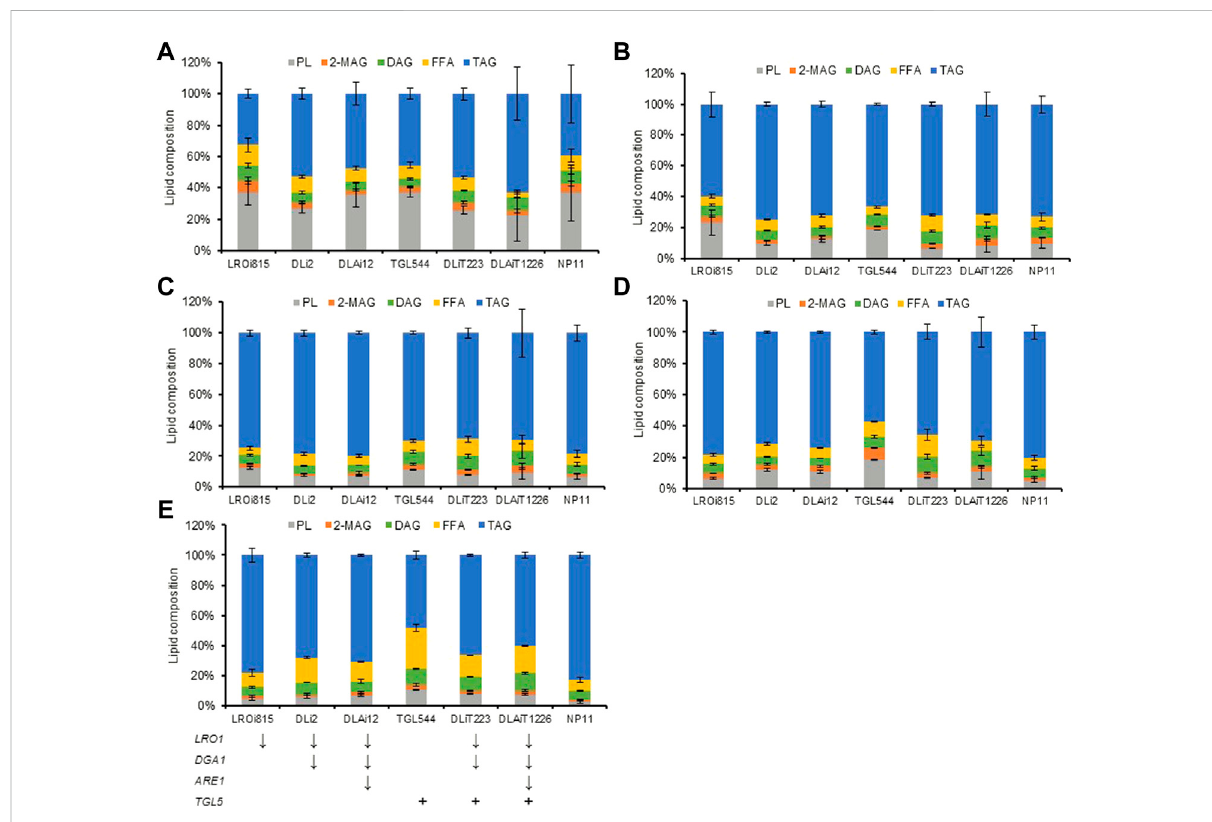
FIGURE 4 Lipid compositions of strains from 72 h to the end of lipid production under nitrogen limitation. The quenching cells at different stages of lipid production were used for glass beading lipid extraction for analysis of lipid compositions. TAG, triacylglycerols; DAG, diacylglycerols; FFA, free fatty acids; 2-MAG, 2-monoglyceride; PL, polar lipids; (A) 72 h (B) 96 h (C) 120 h (D) 144 h. (E) The ending